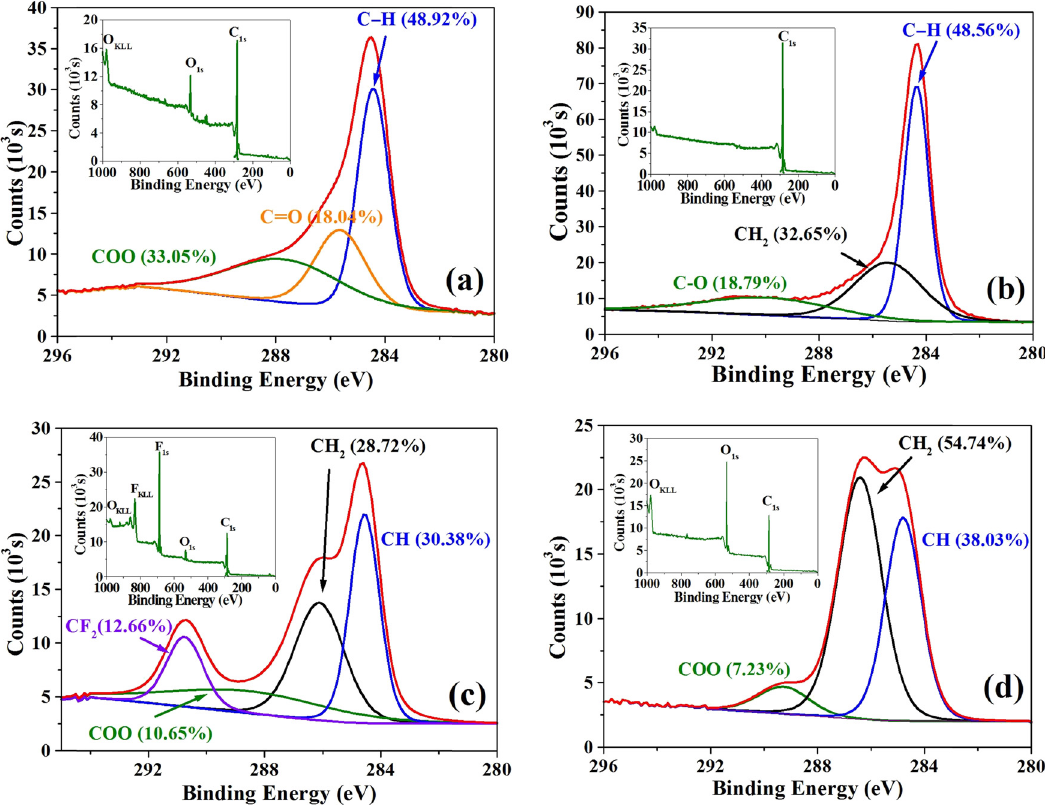
Figure 4: XPS spectroscopy of ( a ) mAC, ( b ) Gt, ( c ) mAC/Gt/PVDF, and ( d ) mAC/Gt/PVA - GA.